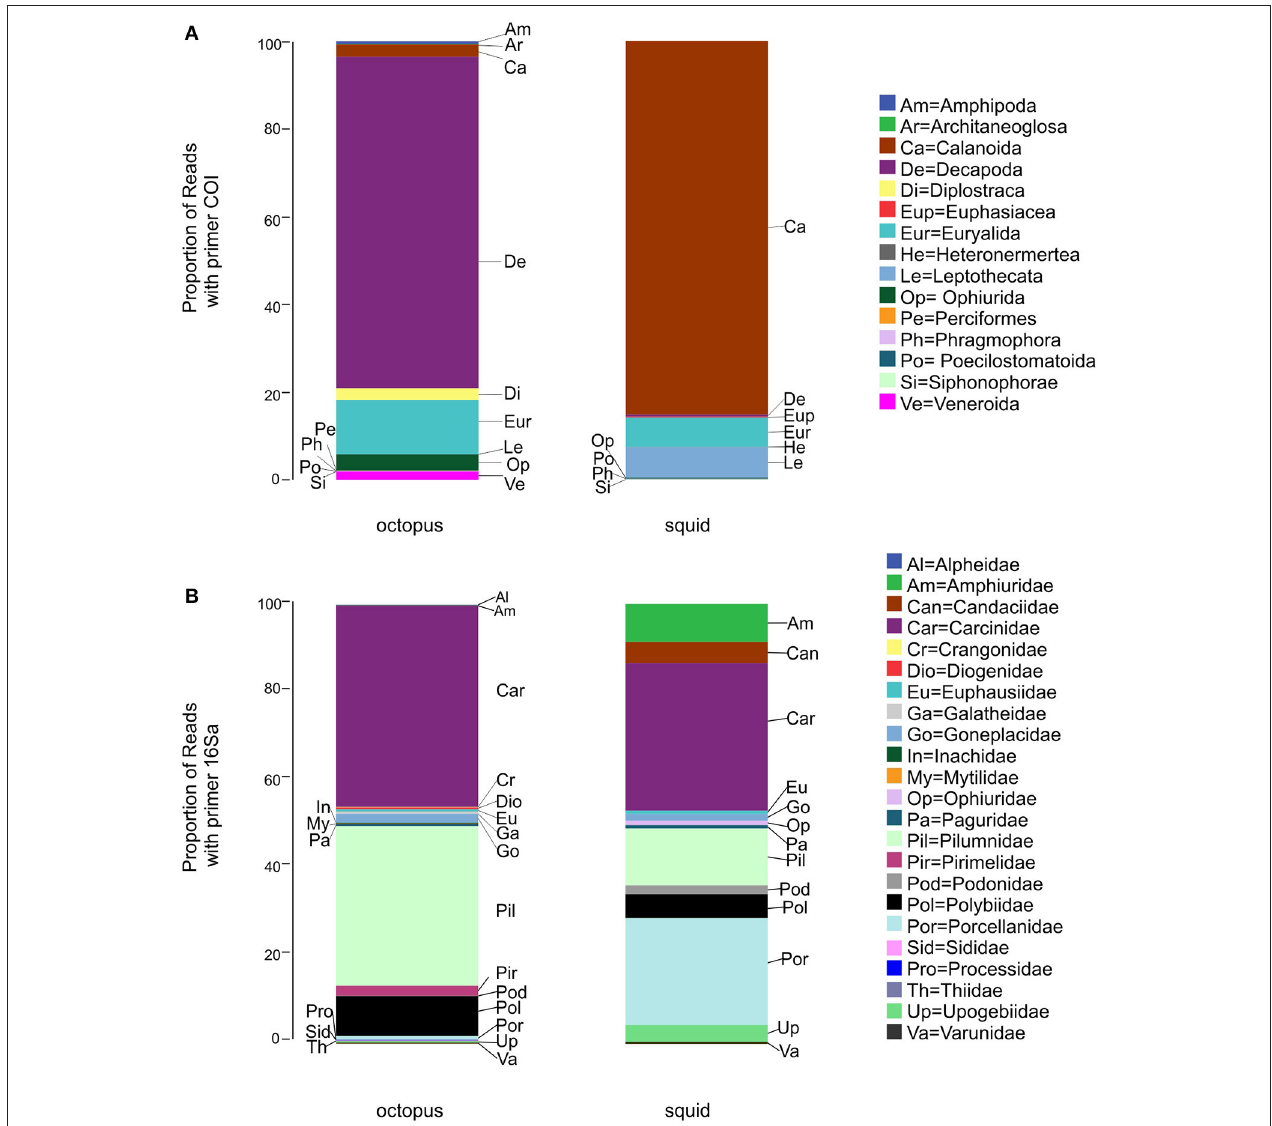
FIGURE 2 | Proportion of Molecular Operational Taxonomic Units (MOTU) prey reads (PR) detected with the primer COI (A) and the primer 16Sa (B) in O. vulgaris and A. media . MOTUs were clustered in orders (A) or families (B) .